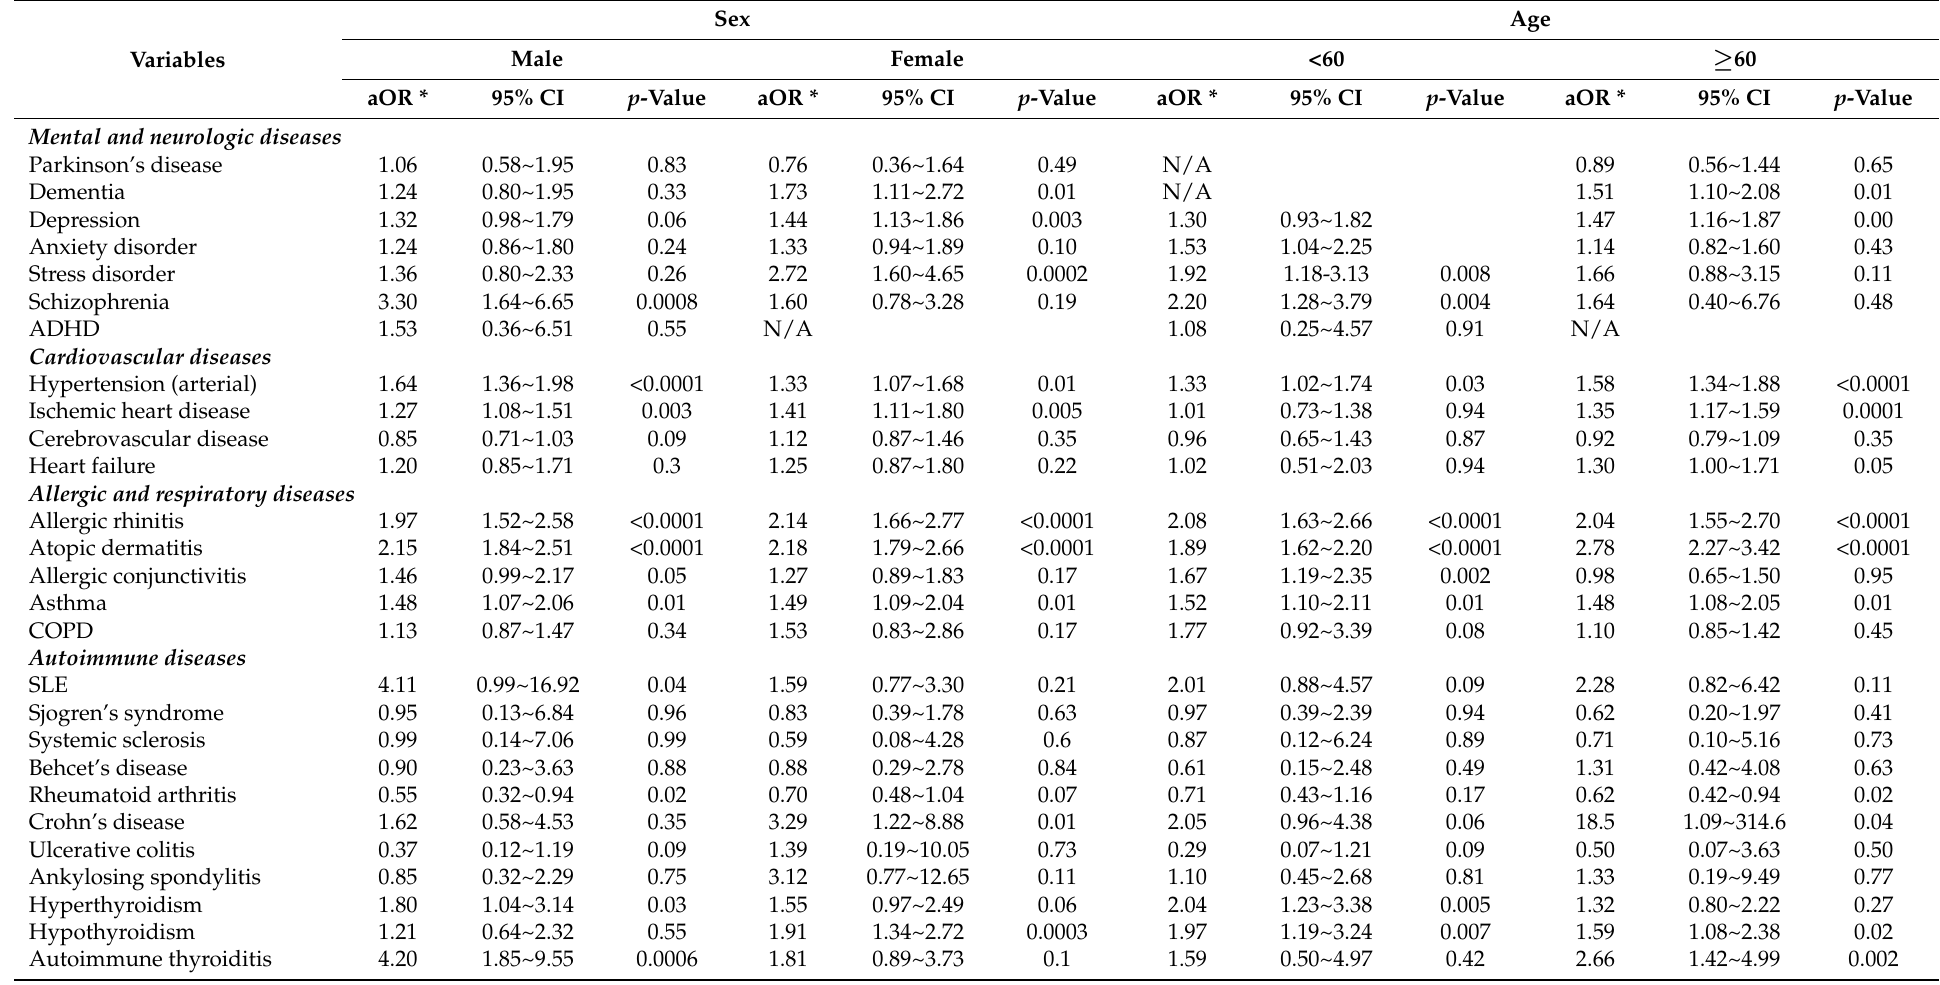
Table 4. Association between PN and various systemic